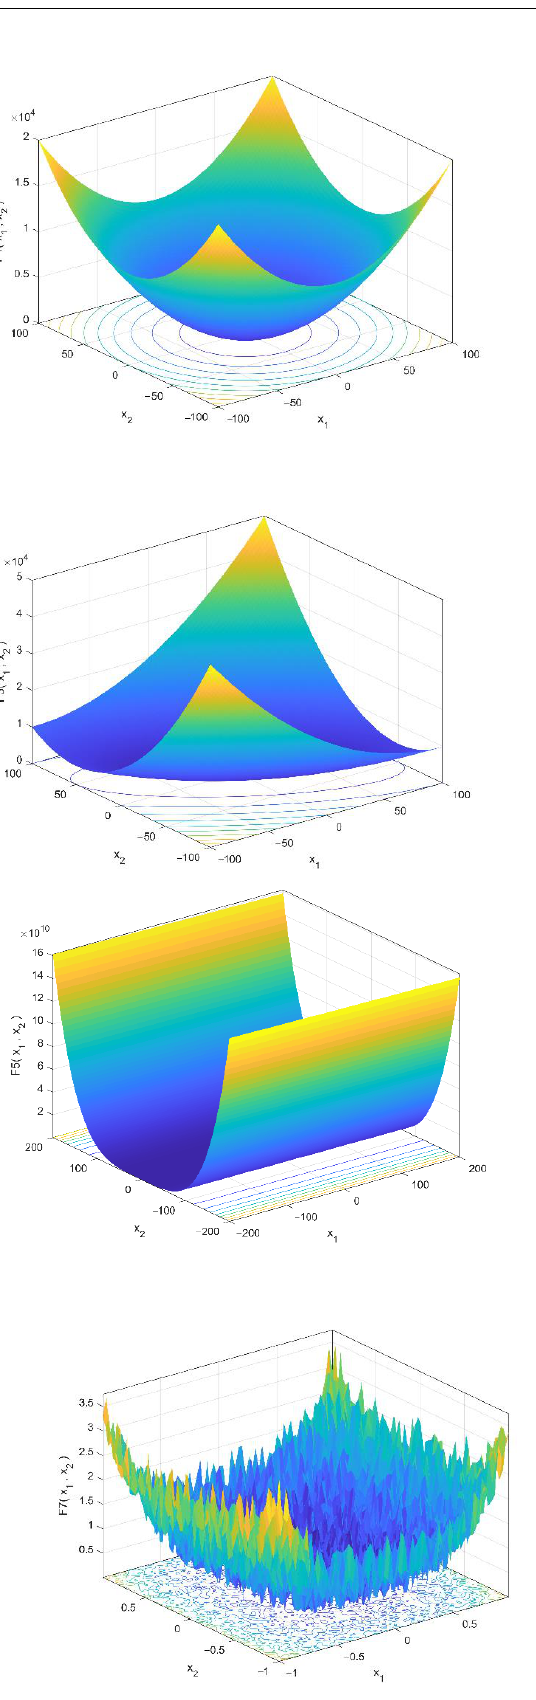
Figure 2. 3-D versions of unimodal benchmark functions.